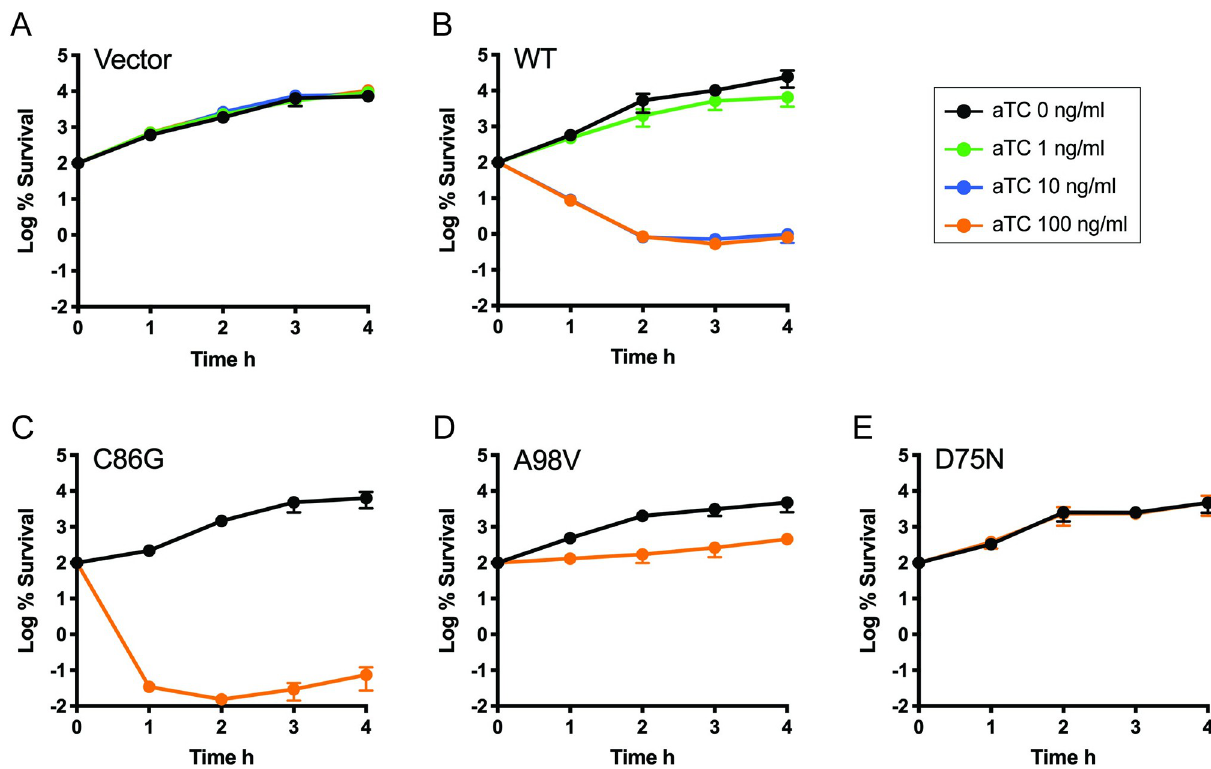
Fig 4. Toxicity of M.BatI variants in E . coli . The number of colony forming units was determined after induction at 0 h with aTc for E . coli strains expressing (A) no M.BatI, (B) wildtype M.BatI, (C) M.BatI C86G, (D) M.BatI A98V, and (E) M.BatI D75N. Black, no induction; Green, aTc 1 ng/ml; Blue, aTc 10 ng/ml; Orange, aTc 100 ng/ml.